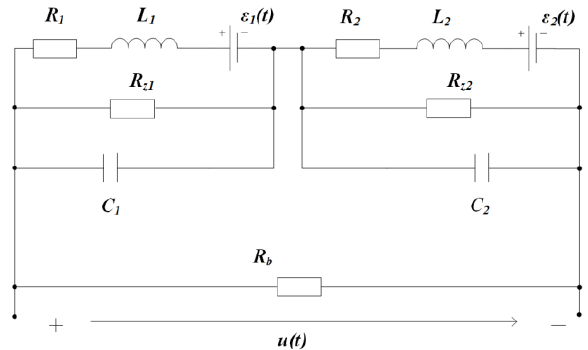
Figure 8. Model 3: Dual-damping resistance equivalent circuit.